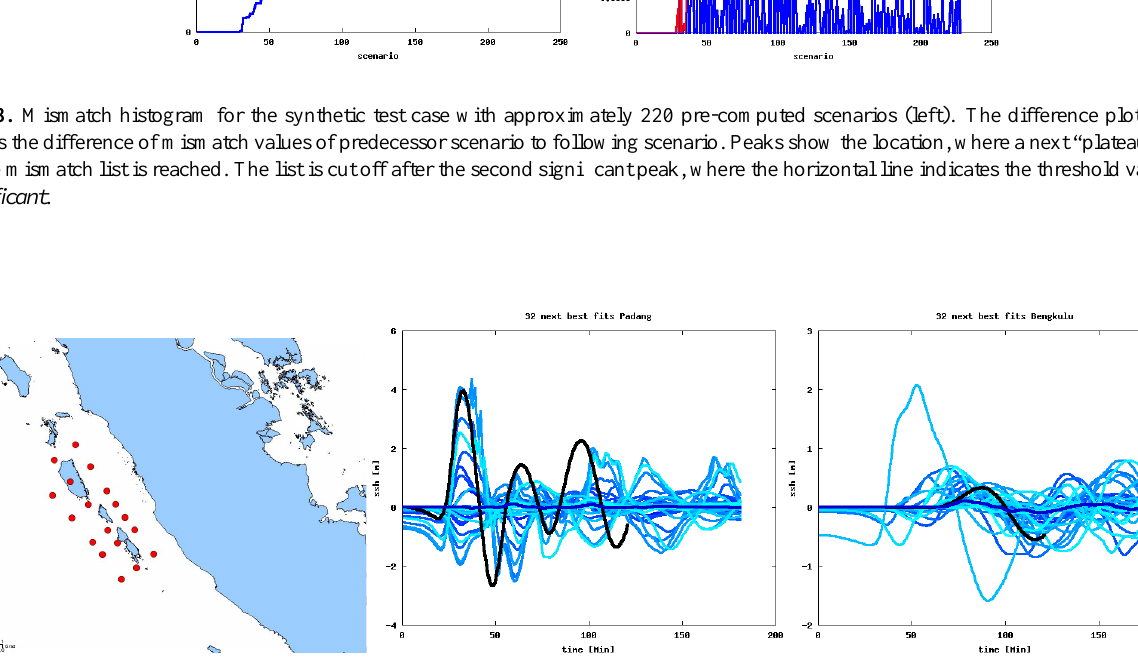
Fig. 9. Benchmark experiment with given seismic parameters. The locations of matching scenarios (left) and the corresponding mareograms in comparison with the benchmark gauge time series for Padang (center) and Bengkulu (right) are shown. Dark color indicates small mismatch, light color larger mismatch.